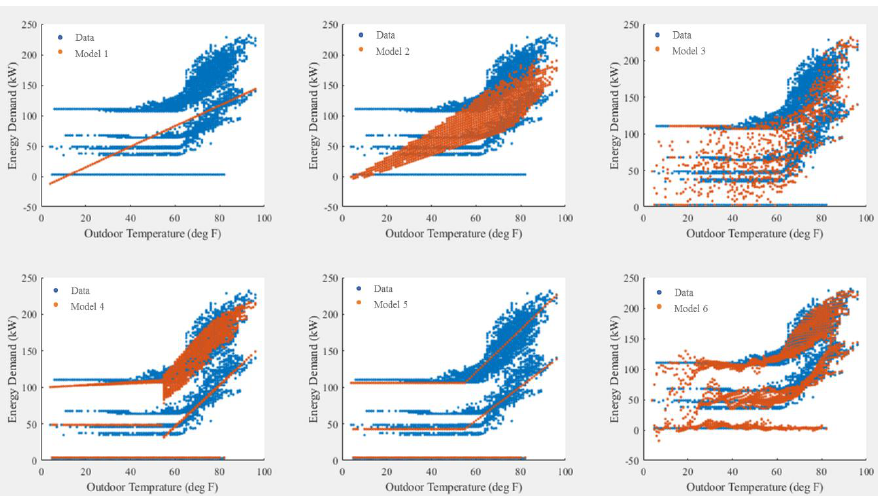
Figure 10. Prediction performance of all models for Building 1.